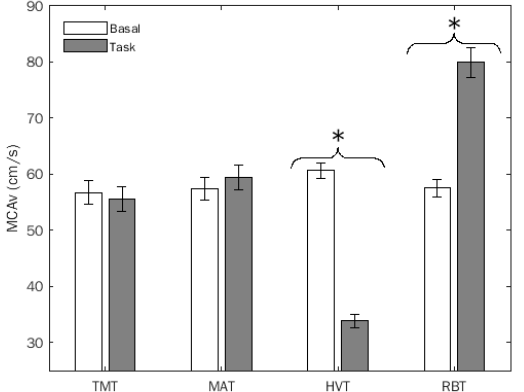
Figure 2. Middle cerebral artery flow velocity (MCAv) (mean, SEM) of the entire sample. TMT: trail making task; MAT: mental arithmetic task; HVT: hyperventilation; RBT: rebreathing. *, statistically significant differences.